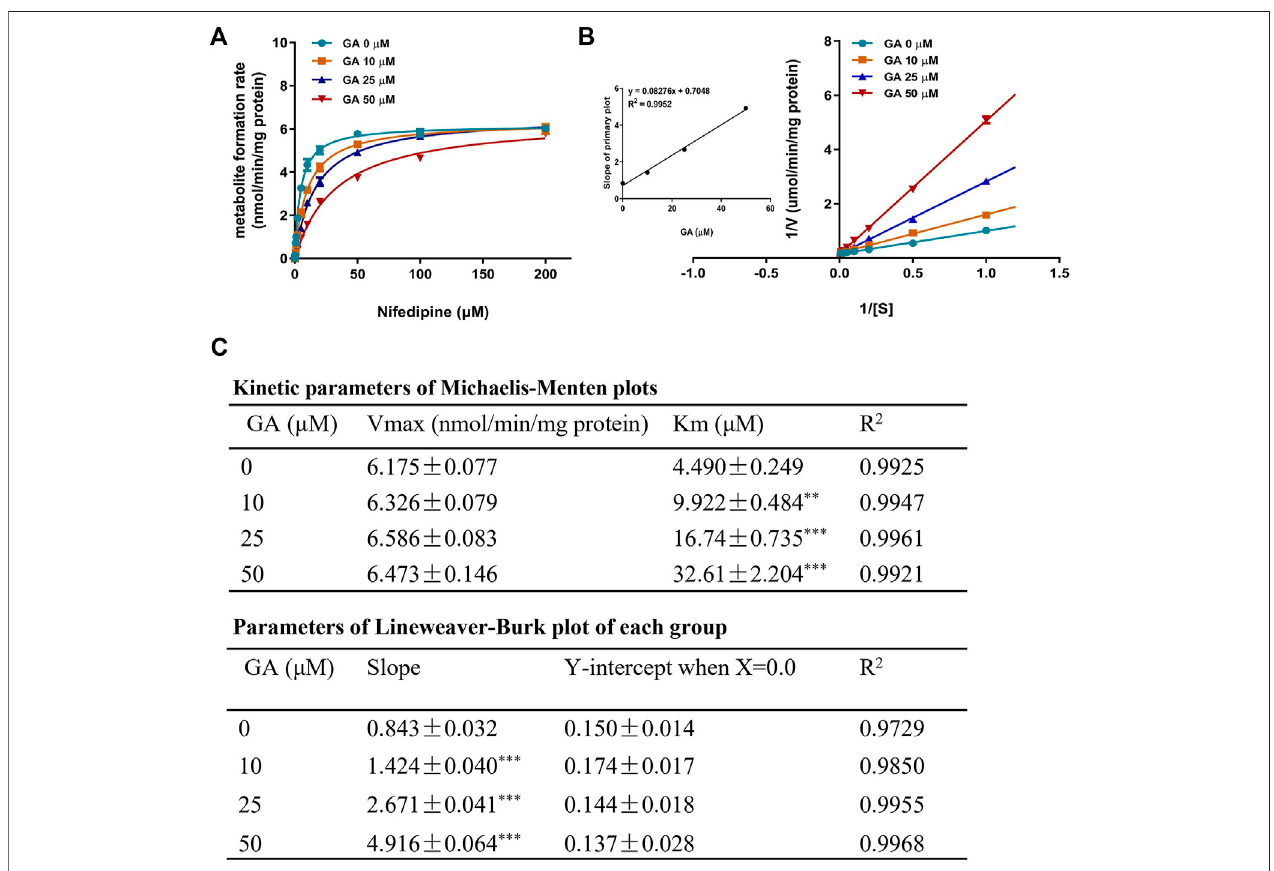
FIGURE 7 | Michaelis-Menten kinetic plot (A) and Lineweaver-Burk plot (B) for K i in the inhibition of rat CYP3A1-mediated metabolism of probe substrate (nifedipine, 0.1 – 200 µM) by GA (0, 10, 25, 50 µM) in rat liver microsomes. The kinetic parameters of Michaelis-Menten plot and Lineweaver-Burk plot (C) . Data are expressed as mean ± SD ( n = 3). ** p < 0.01 and *** p < 0.001 versus the corresponding GA (0 µM)